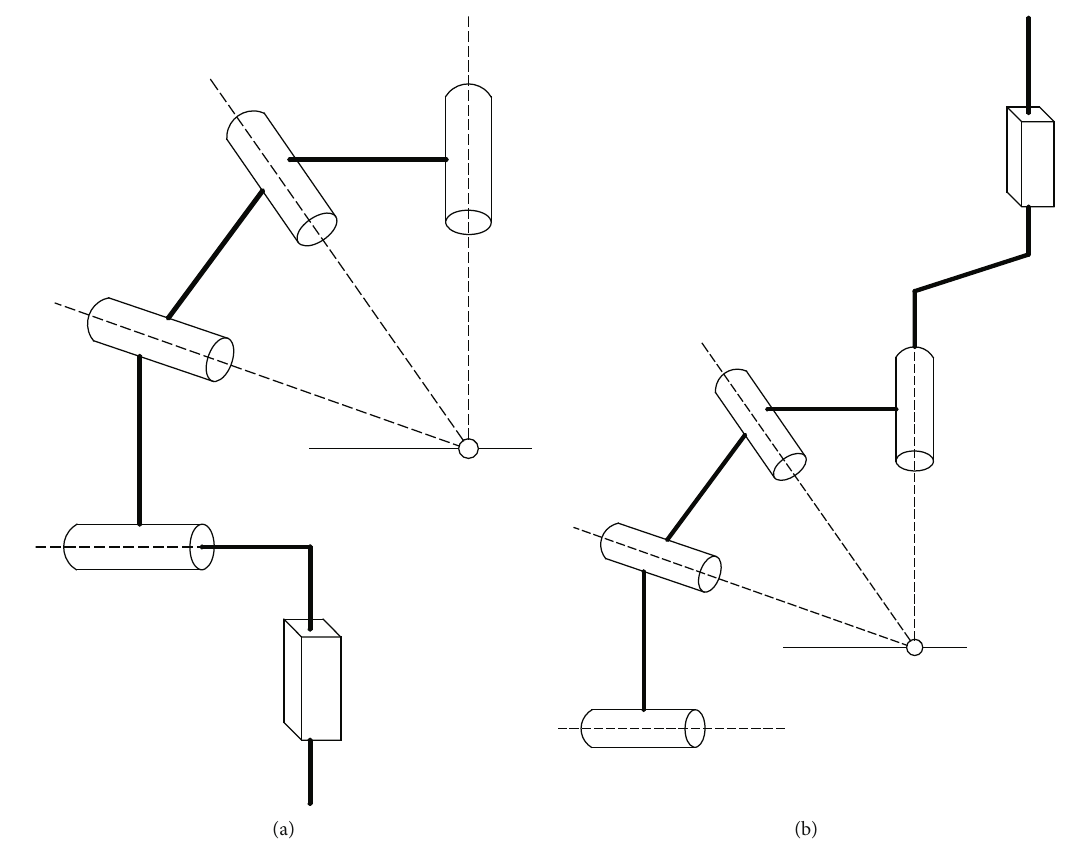
Figure 10: Kinematic units by moving kinematic